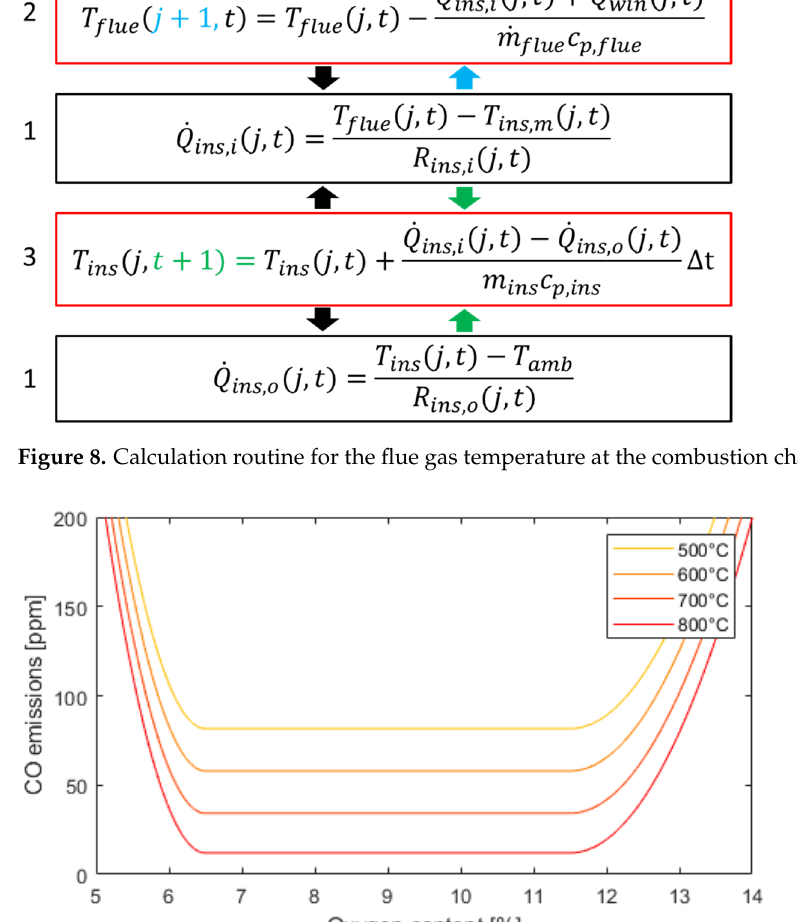
Figure 8. Calculation routine for the flue gas temperature at the combustion chamber outlet.